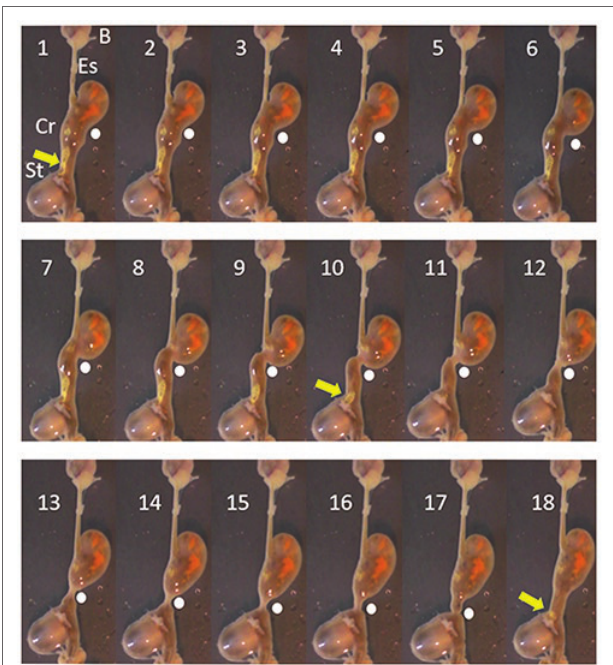
FIGURE 2 | Pictures taken each second (1–18 s) from a video recording of the digestive tract of O. vulgaris , in vitro (in sea water gassed with air). The animal had been fed a crab 1 h before killing (see Fiorito et al., 2015). The sequence shows the progression of a peristaltic wave (indicated by a white dot) from close to its origin and progressing aborally to the crop/stomach junction. The pressure created by the contraction moves material (yellow arrow) from the crop to the stomach and it is no longer visible after Frame 10. In Frame 16, the crop contraction reaches the stomach and in frames 17 and 18, the contraction subsides allowing material (yellow arrow) to reflux from the stomach toward the crop. The vertical axis of the frames is ~8 cm. B, beak; Es, esophagus; Cr, crop; and St,